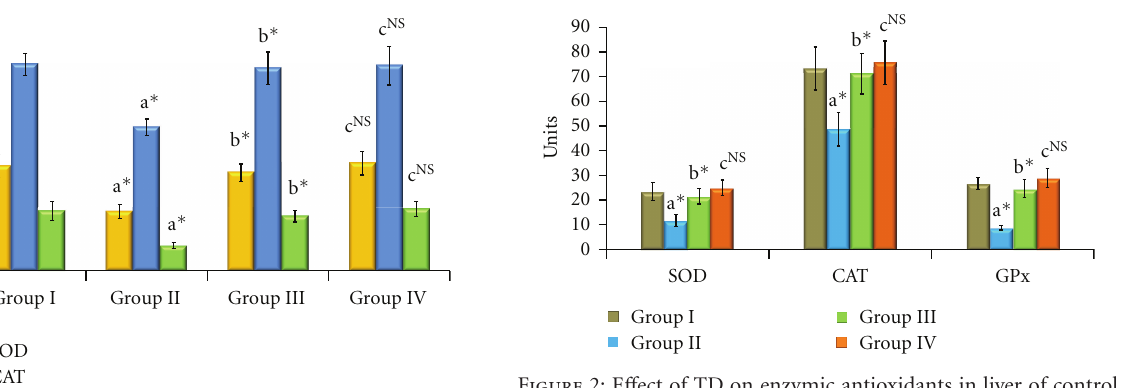
Figure 2: E ff ect of TD on enzymic antioxidants in liver of control and experimental animals. Values are expressed as mean ± SD for six animals. Comparisons are made between “a” Group II versus Group I, “b” Group III versus Group II, “c” Group IV versus Group I. The symbol ∗ represents the statistical significance at P < 0 . 05. NS: nonsignificant. SOD: U/min/mg protein, CAT: µ moles of H 2 O 2 consumed/min/mg protein, GPx: µ moles of GSH oxidized/min/mg